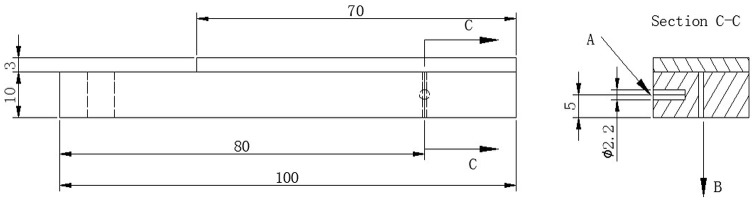
Tactile interface with air outlet.